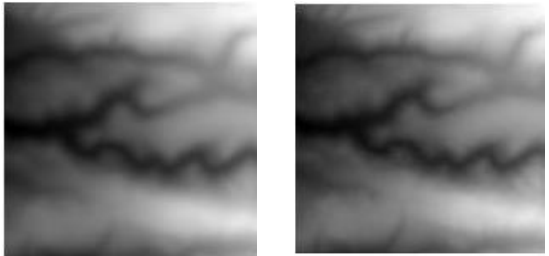
Figure 4. 25 m resolution DTMs: SoI (left) and SRTM (right) for area #1.